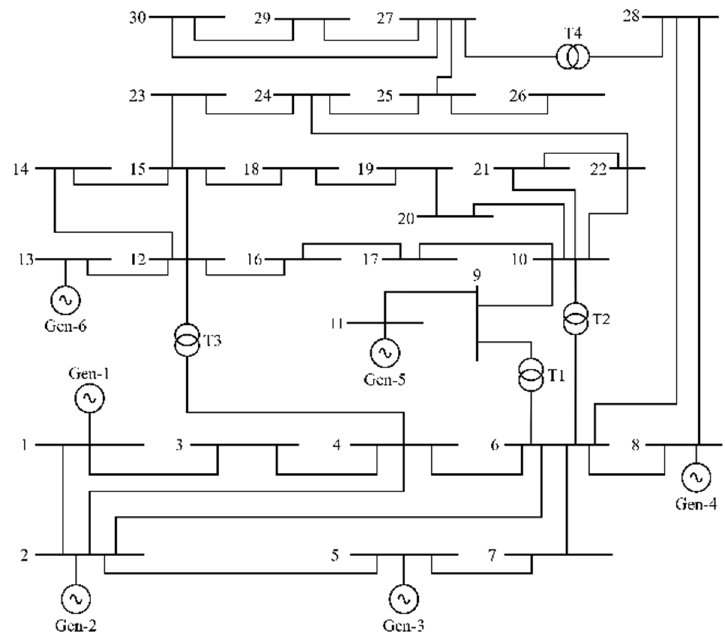
Figure 3. IEEE 30-bus test system.